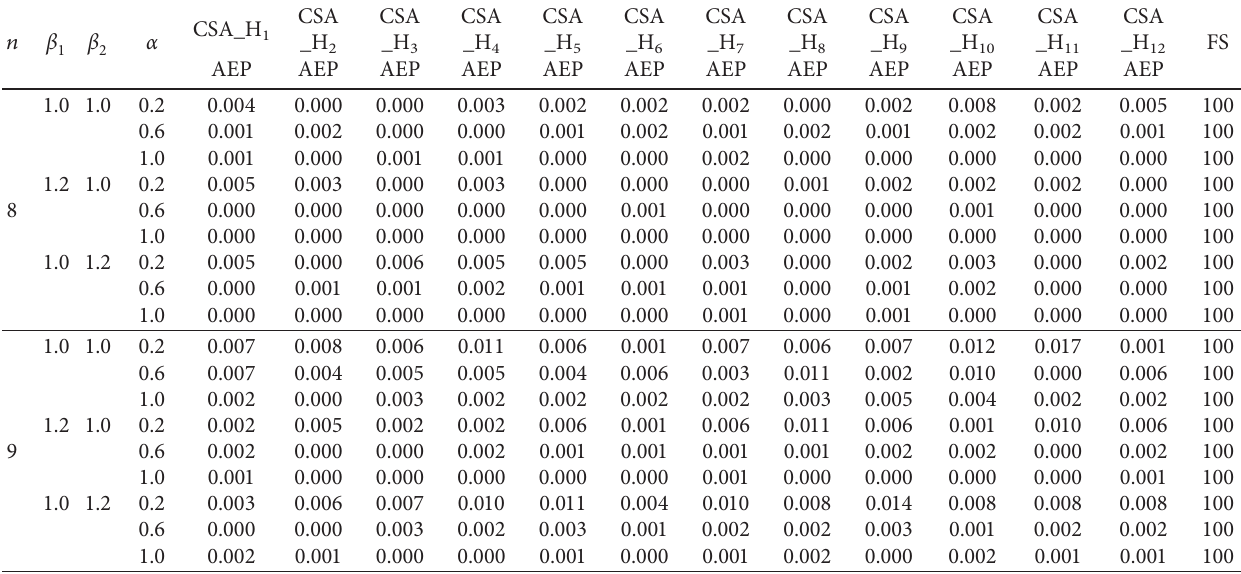
Table 3: The AEP of 12